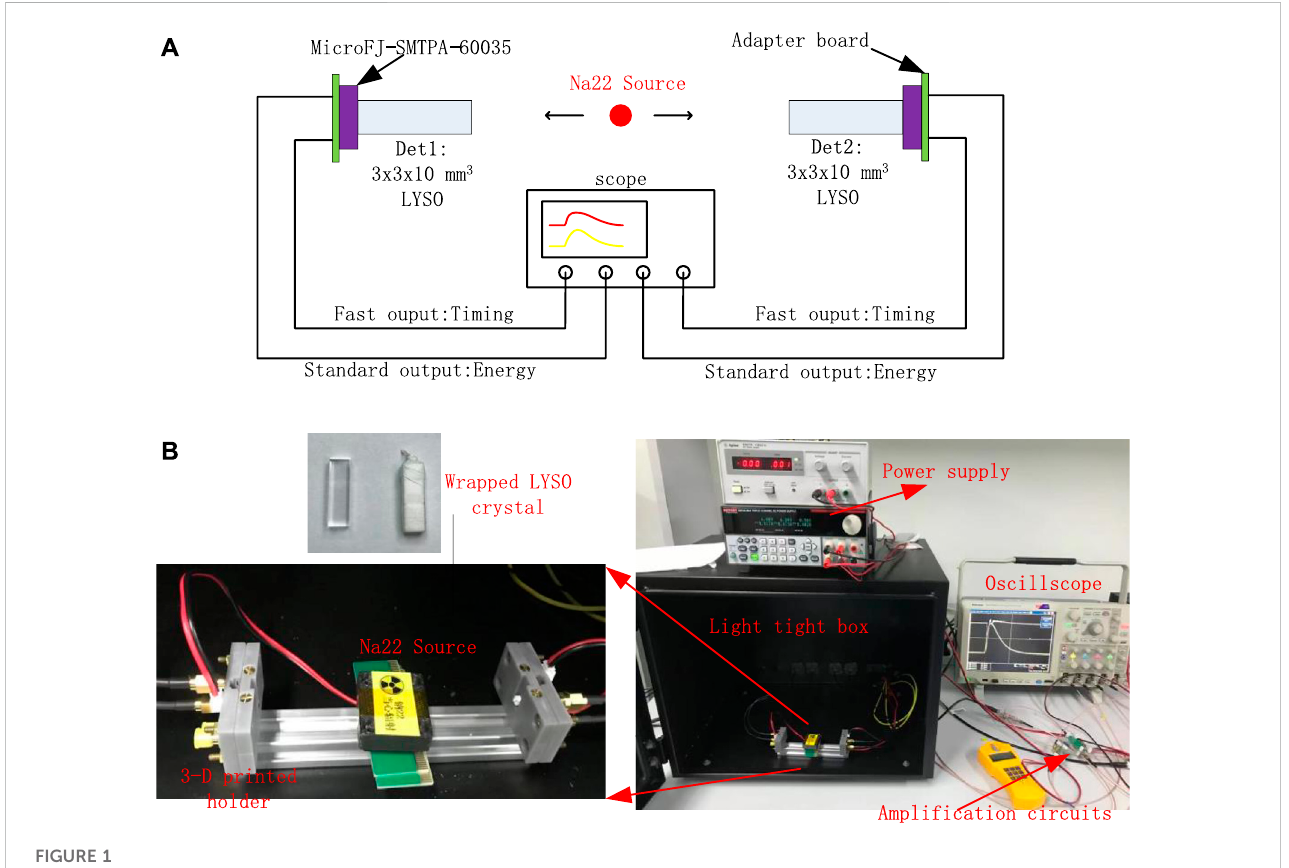
Experimental setup (A) and photograph (B) for timing evaluation.